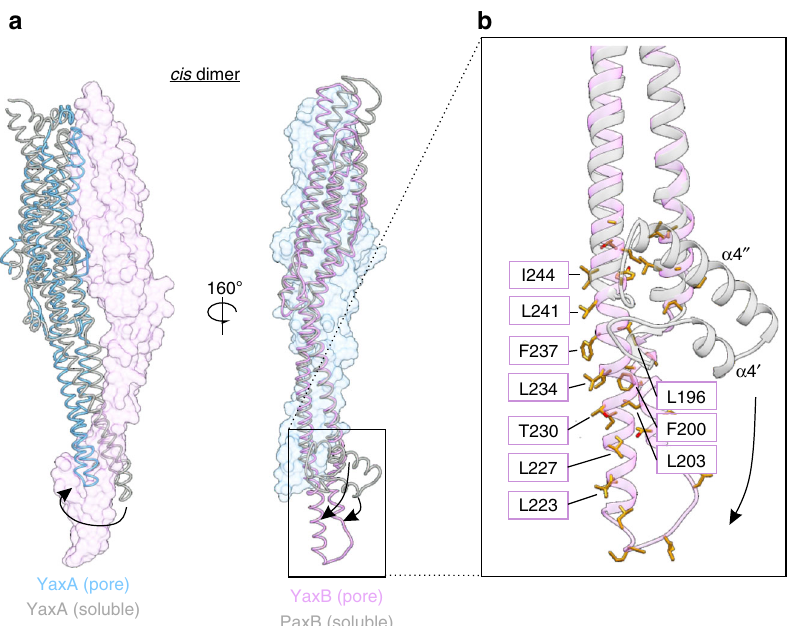
Fig. 5 Conformational changes of YaxA and YaxB upon oligomerization. a Overview of conformational changes within YaxA and YaxB in context of a cis dimer. The interacting protomer is shown in transparent surface representation. Alignment has been carried out between head domains only, given the small rearrangements in this region. Left: monomeric (gray) and protomeric (blue) YaxA. Right: monomeric PaxB (gray) and protomeric YaxB (pink). Arrows emphasize the structural rearrangements during oligomerization. b Details of the conformational change in the YaxB/PaxB foot domain transitioning from monomeric to protomeric states. This depiction illustrates the extrusion of the domain ’ s hydrophobic core. Apolar side chains are colored in